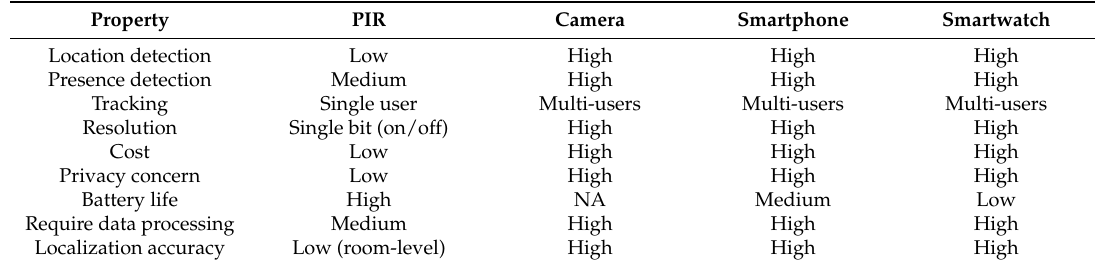
Table 1. Sensing technologies—Properties